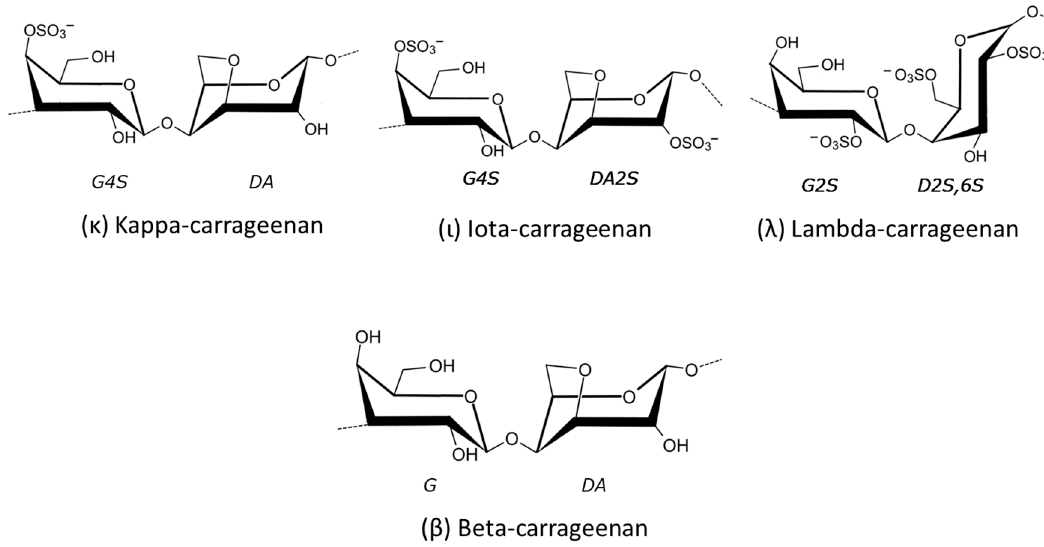
Figure 3. Idealized units of the main types of Carrageenan. Adapted from [145].